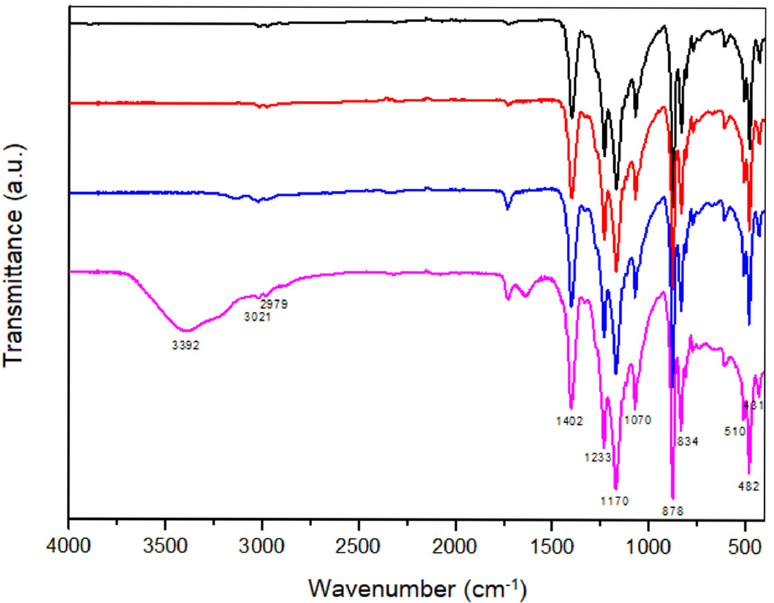
Figure 3. Fourier-transform infrared spectra analysis. The FTIR spectra of the plain PVDF membrane (black line), NAs (red line), DMP (blue line), and combination of the NAs and DMP (pink line) on the PVDF membrane are indicated. PVDF, polyvinylidene fluoride; NA, nucleic acid; DMP, dimethyl pimelimidate.